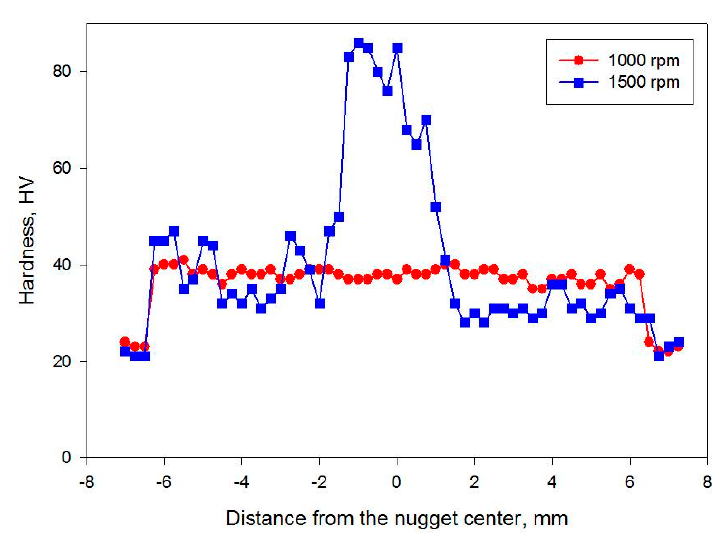
Figure 4. SEM image of the Fe particles dispersed in some areas produced by triple FSP passes at a rotation speed of 1500 rpm: ( a ) nugget center; ( b ) area involving Fe particles of high density; ( c ) Fe particles cluster; and ( d ) cracks in an area involving Fe particles of high density.